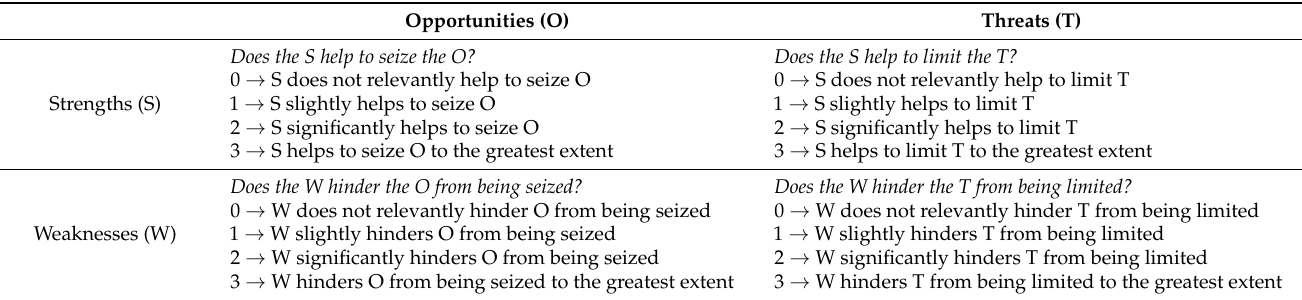
Table 1. Interactions between Strengths/Weaknesses and Opportunities/Threats and criteria for the assignment of the score (0, 1, 2,